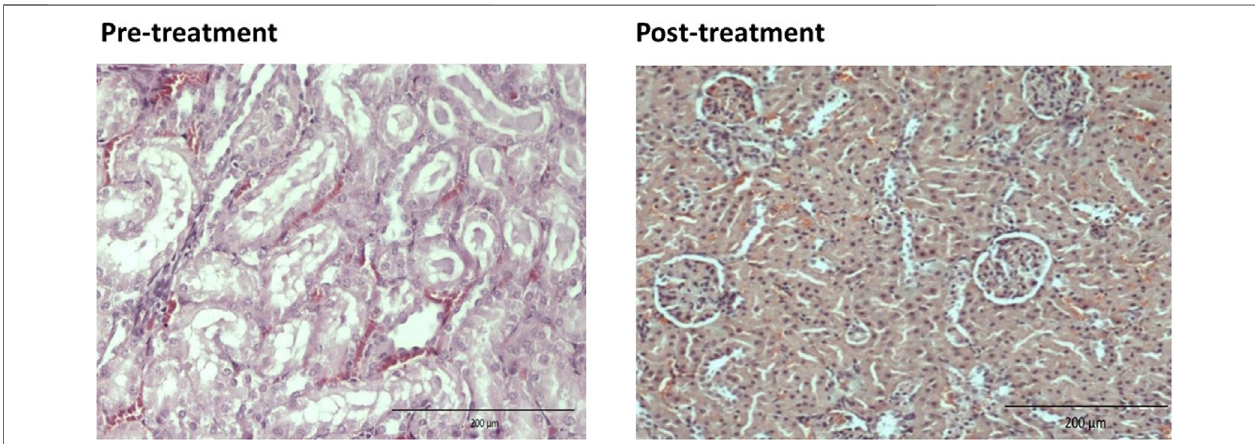
FIGURE 1 | Control-Normal renal tubles and glomeruli (Hematoxylin and Eostin stain).